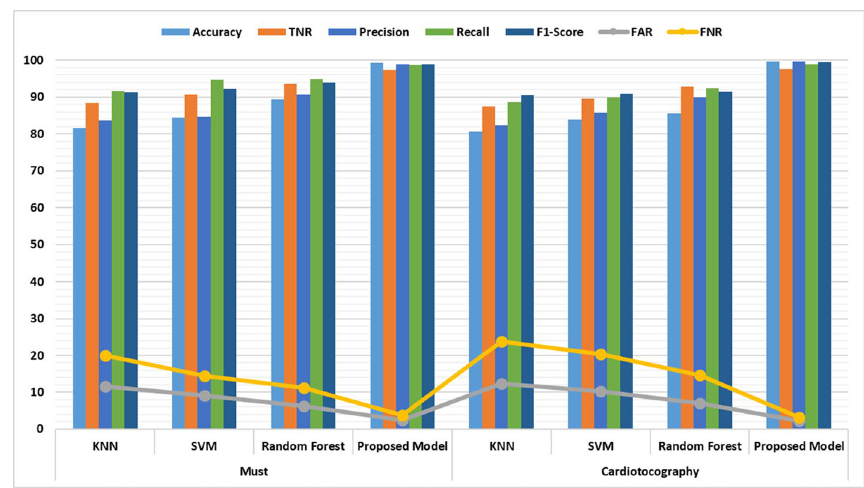
Fig. 7 Performance Comparison between ML methods and the proposed